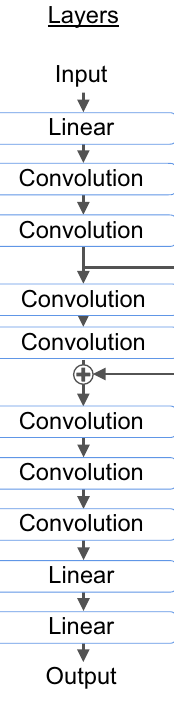
duction triggering environment, e.g. featuring many more trigger